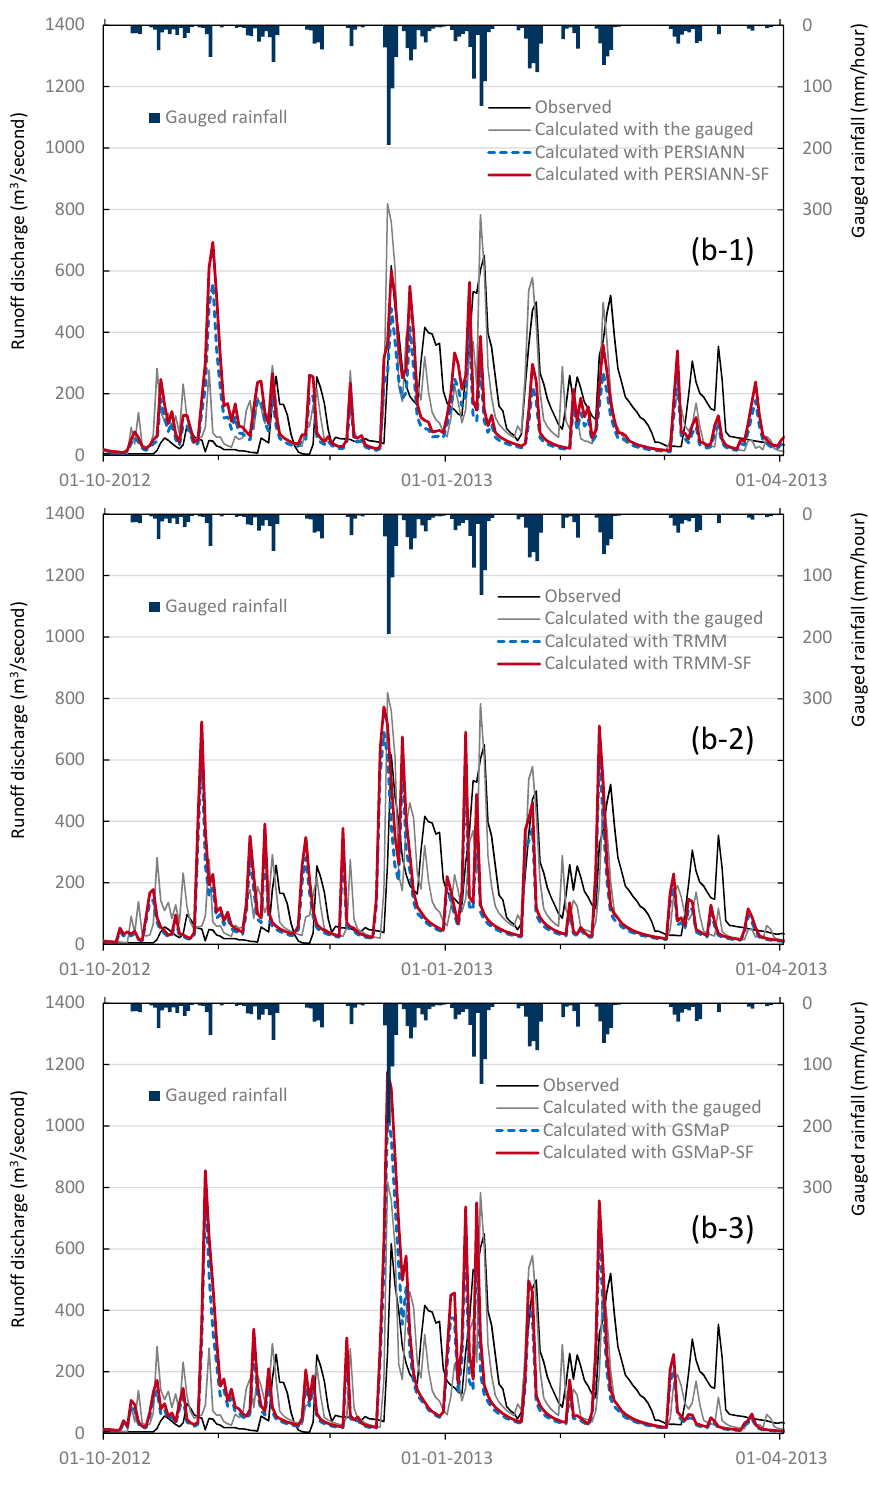
Figure 5. Hydrographs at Tampitiya produced with Gauged-R data and that of the SREs for the calibration period (from October 2010 to March 2011; ( a1 )–( a3 )) and part of the verification period (from October 2012 to March 2013; ( b1 )–( b3 )).